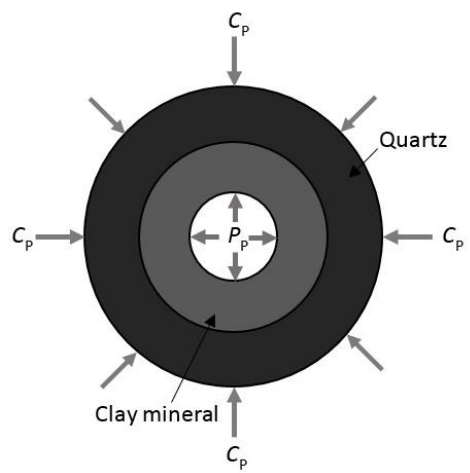
Figure 26. Conceptual model of flow channel structure in clay-abundant sample [49].